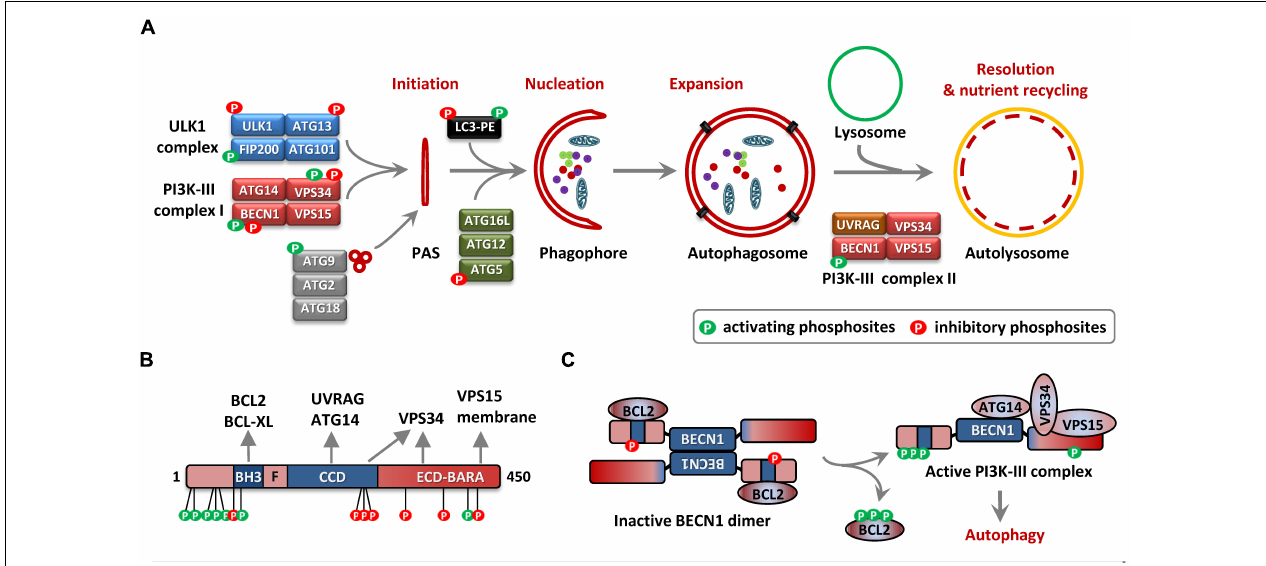
FIGURE 1 | Autophagy and Beclin 1 (BECN1) phosphorylation. (A) The scheme depicts the phases of autophagosome assembly from initiation to nutrient recycling. The steps include the structural transformation from the pre-autophagosomal structure (PAS) to phagophore to autophagosomes, culminating in the fusion of autophagosomes with lysosomes facilitating the degradation of their contents in autolysosomes. The regulatory protein complexes involved are depicted with their components and the presence of regulatory phosphorylation event/events are shown. (B) Primary structure of BECN1 showing the BCL2/BCL-XL binding BH3 motif (residues 105–130), flexible helical domain (F, residues 141–171), and the central coiled coil domain (CCD, residues 175–265). Evolutionary conserved domain (residues 248–337) and β / α -repeated, autophagy-related (BARA) domain (265–450aa) is represented together as ECD-BARA (Mei et al., 2016). The approximate locations of pro-autophagy (green) and inhibitory (red) phosphorylation sites are shown. The contributions of the different domains to complex formation with interactors are also indicated. (C) Phosphorylation-dependent conversion of inactive BECN1 homodimer/BCL2-complex to an active PI3K-III complex is depicted. The STK4-mediated BECN1-BH3 domain phosphorylation (negative regulator of autophagy), triple phosphorylation of BCL2 which releases BCL2 from BECN1, representative phosphorylation events in the N-terminal domain (NTD) promoting BECN1-BCL2 dissociation as well as activating the PI3K-activity are presented (positive